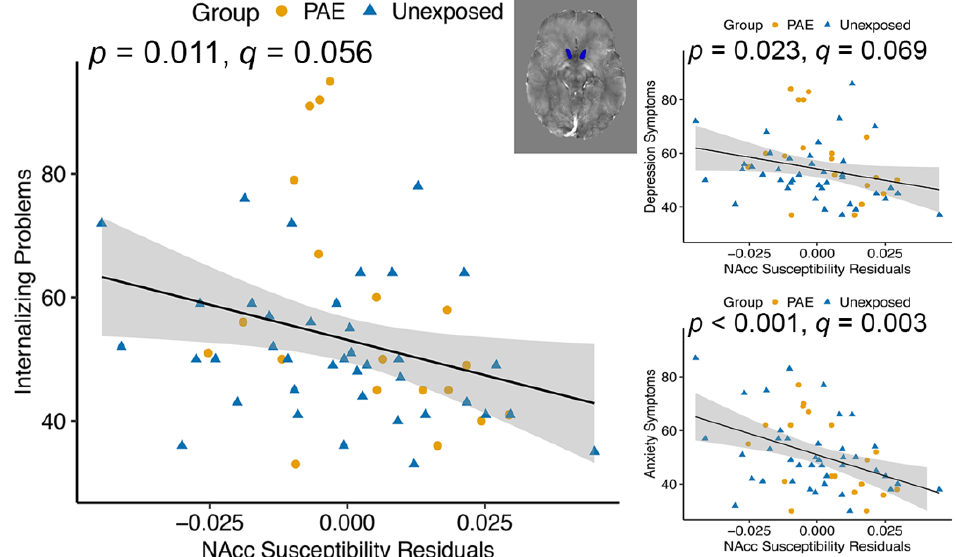
Figure 2. Nucleus accumbens (NAcc) magnetic susceptibility was negatively associated with BASC-2-PRS T scores Internalizing Problems, Depression, and Anxiety symptoms in youth with and without PAE. The p values indicate the main effect of susceptibility on Internalizing Problems, Depression, and Anxiety, and susceptibility values are corrected for age and gender.